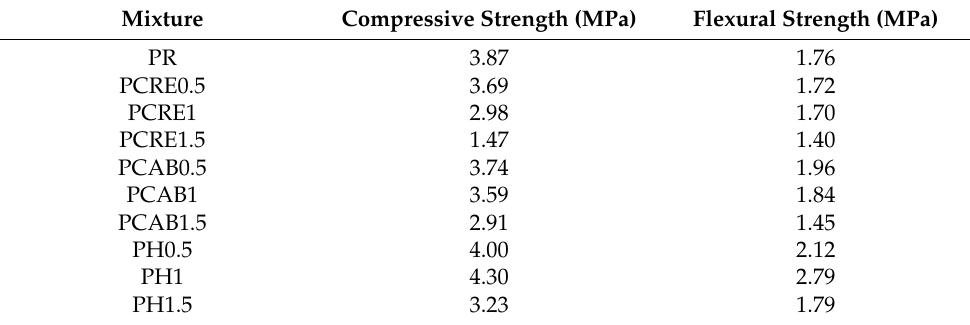
Table 4. Compressive and flexural strength of studied